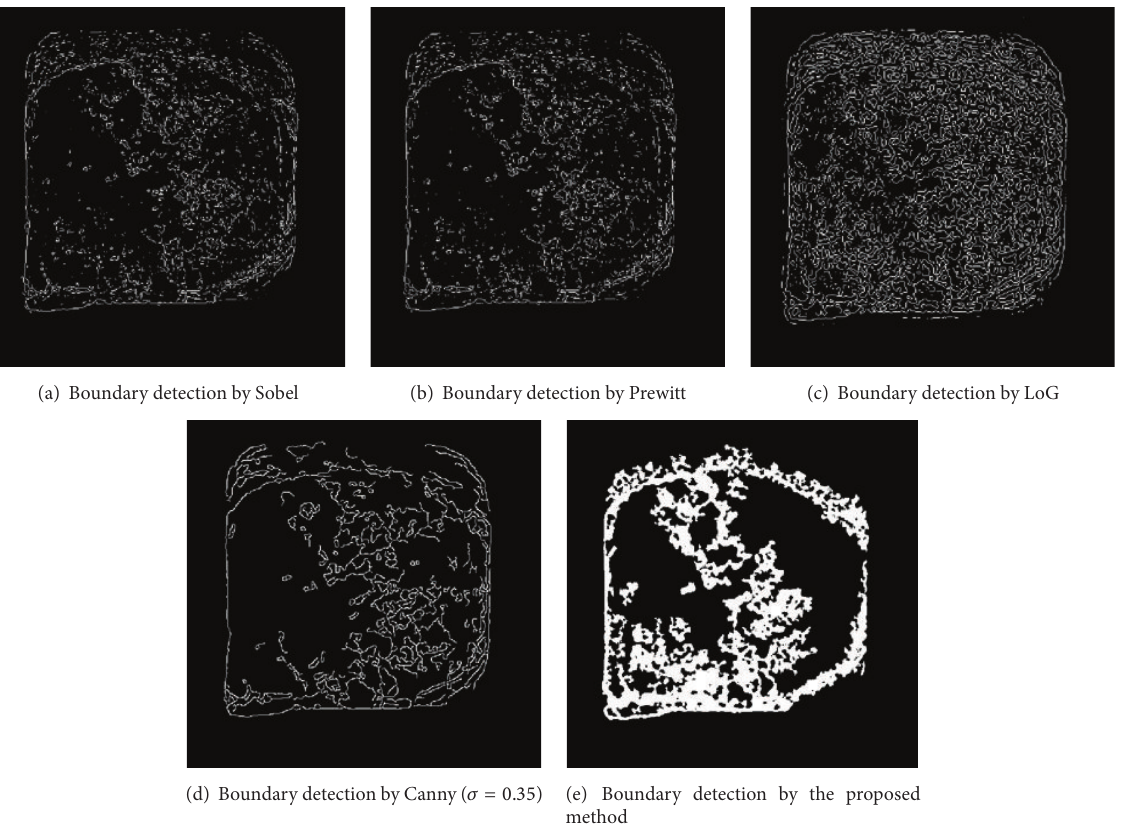
Figure 14: Comparison between conventional edge detection techniques and the proposed method for cube T1 (submerged for 90 days).